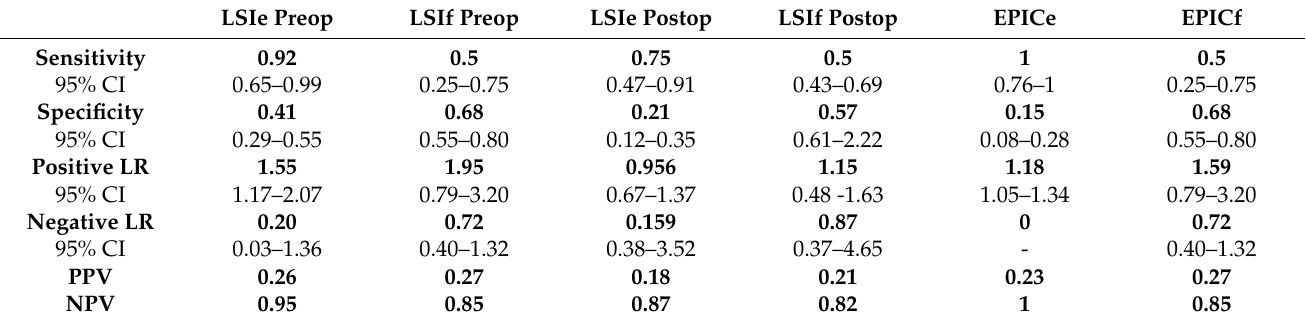
Table 5. Sensitivity and specificity of muscle strength indexes as tests for prediction of second ACL